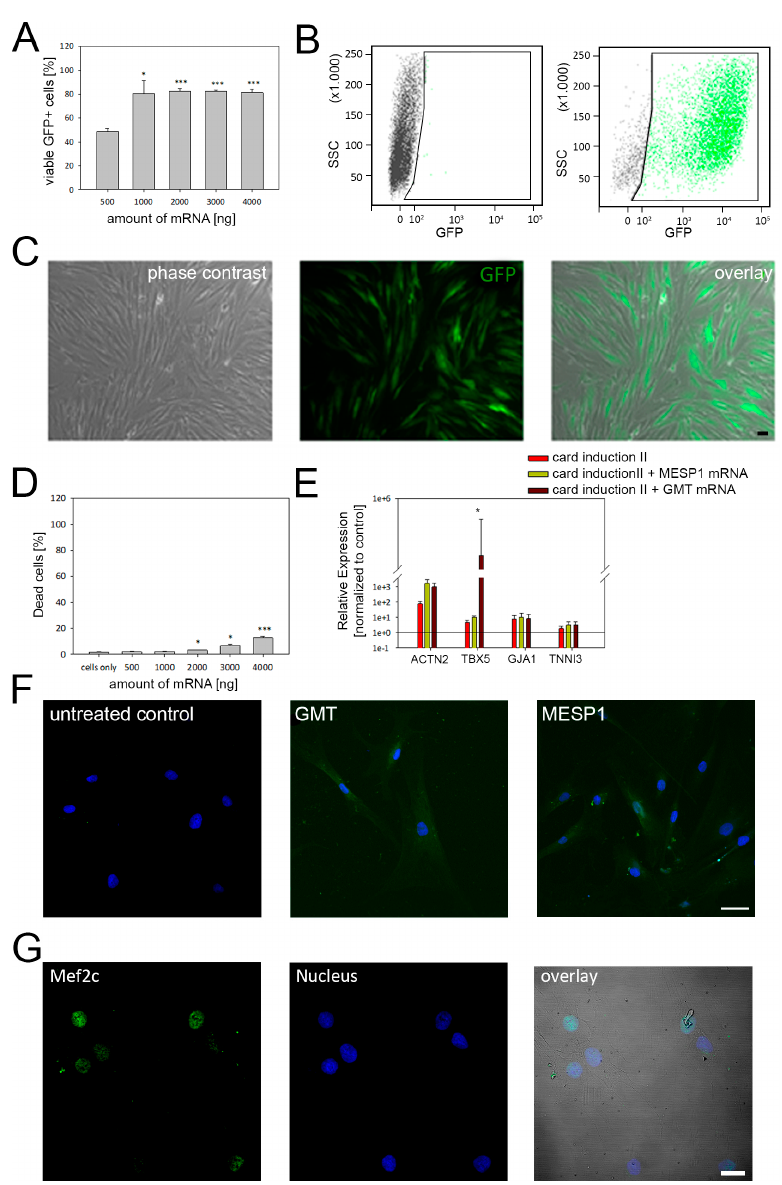
Figure 4. mRNA-based cardiac programming of adMSC. ( A ) Concentration-dependent expression of transfected mRNAs was evaluated with mRNA coding GFP. The quantative flow cytometry analysis demonstrated maximum transfection efficiency of ~80% when ≤ 1000 ng mRNA were applied. ( B ) Representative scatterplots of control cells (left) and cells transfected with GFP mRNA (right). ( C ) Corresponding microscopy images of cells expressing GFP following mRNA treatment. ( D ) Cytotoxic effects were only induced when mRNA amounts higher than 1000 ng were used for transfection. ( E ) Compared to untreated control cells, higher gene expression levels of selected cardiac markers were detected for all reprogramming conditions, in particular for α -actinin. ( F ) Immunolabeling of cells using anti α -actinin antibody results in a faint fluorescence signal in cells transfected with MESP1 and GATA4, MEF2C, and TBX5 (GMT) mRNAs, Scale Bar: 25 µ m. ( G ) Moreover, GMT treated cells also demonstrated protein expression of MEF2C, an early cardiac transcription factor. Flow cytometry and qRT-PCR data are shown as mean ± SEM, obtained from three di ff erent donors. Statistical analysis was performed using one-way ANOVA. * p ≤ 0.5, ** p ≤ 0.05, *** p ≤